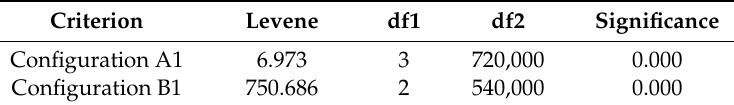
Table 15. Variance homogeneity test result of fuel cell output power.